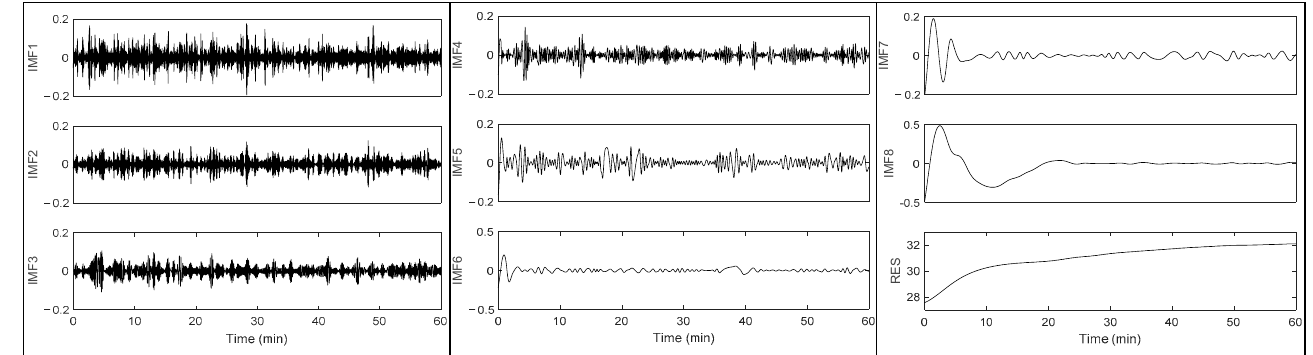
Figure 3. Comparison between the original (red curve) and filtered signals (black curve) with the help of the EMD-FSI noise suppression algorithm. The filtered signal was reconstructed from IMF5 to IMF8 along with the residue, while the rest (IMF1 to IMF4) was discarded in the process of signal reconstruction as their FSI values were less than the threshold.